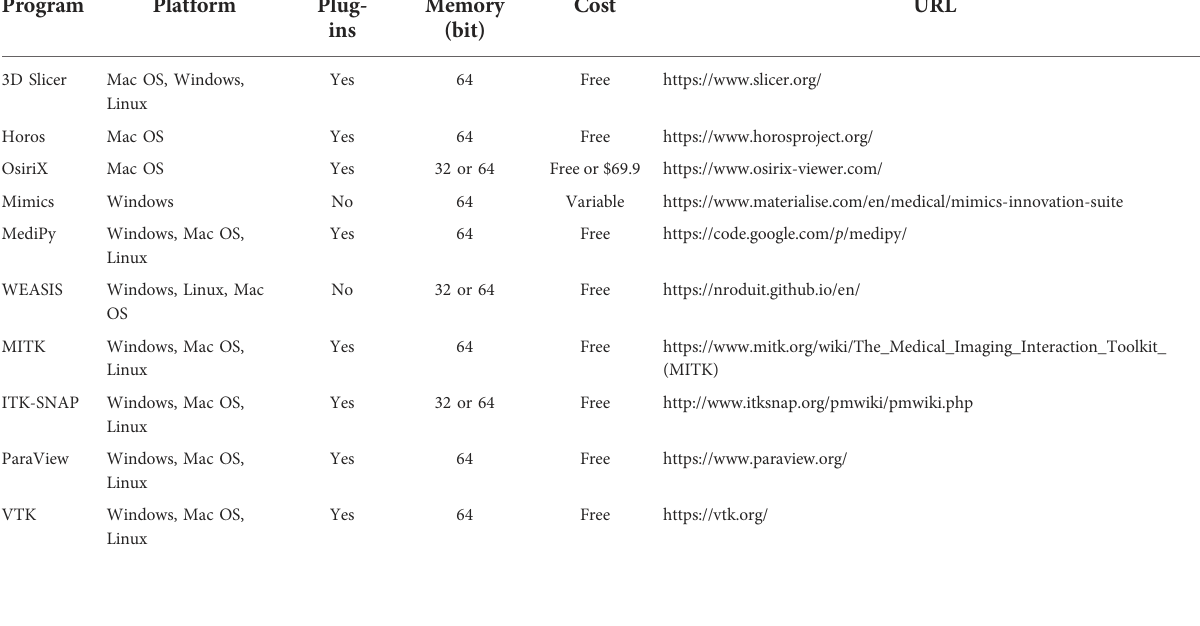
TABLE 1 Commonly available digital visualization